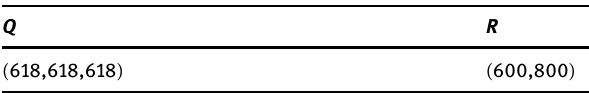
Table 3: MPC weight on controller errors and